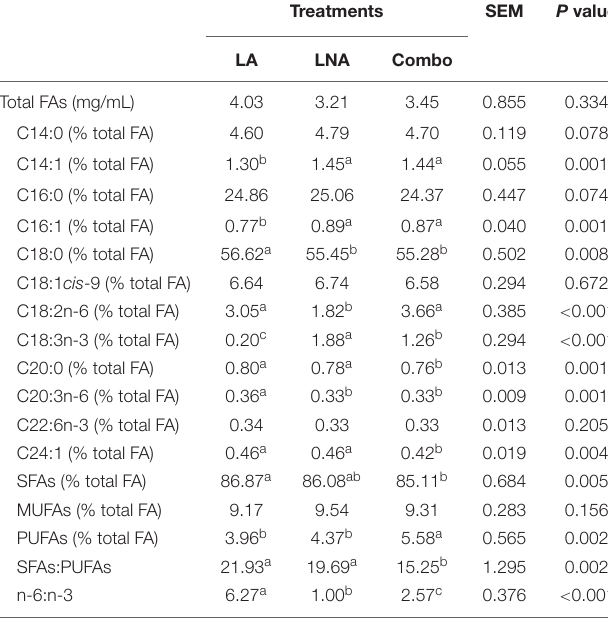
TABLE 5 | Effects of fatty acid supplementation on the fatty acid profiles of rumen buffer after 8 h of incubation. Treatments SEM P